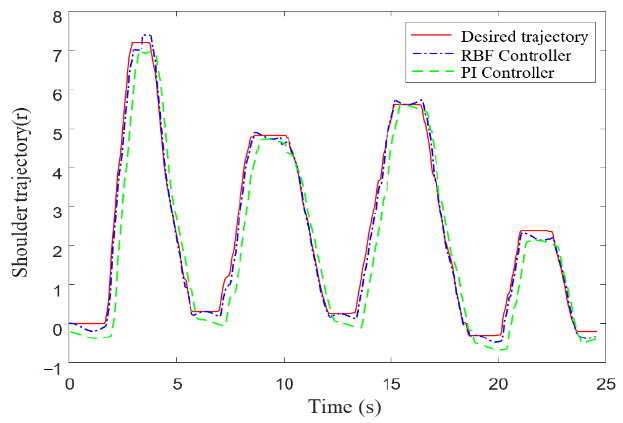
Figure 7. Elbow joint trajectory diagram.